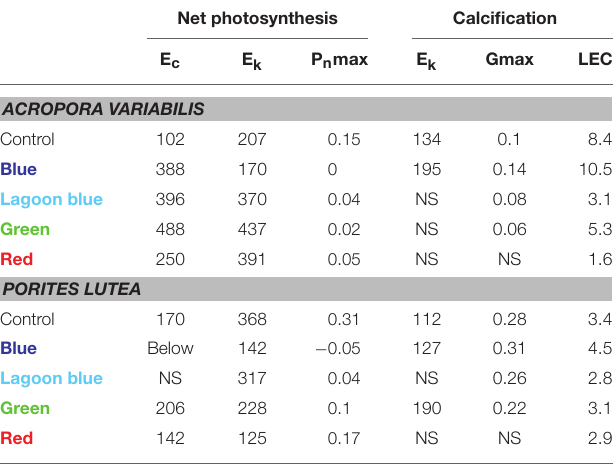
TABLE 1 | All replicates of A. variabilis and of P. lutea were combined to calculate a single hyperbolic tangent function (Chalker, 1981) for each color.